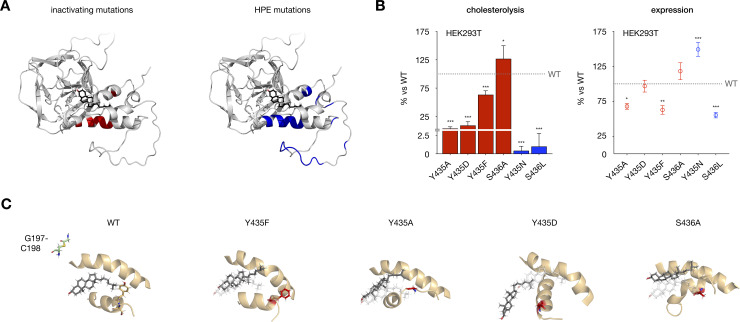
Disease-associated SRR mutations perturb hSHH cholesterolysis.(A) Model of the cholesterol-Hog complex, showing residues essential for cholesterolysis of full-length hSHH protein in HEK293T cells (red; see ref 17) and residues identified in holoprosencephaly (HPE) patients (blue). (B) Relative cholesterolysis efficiency and total expression of full-length hSHH and mutant proteins overexpressed in HEK293T cells, evaluated by quantitative Western blot. Values are the average of 3–9 biological replicates ± s.d. For cholesterolysis, one-way ANOVA, F(6,37) = 121.3, P value P < 0.001, Dunnett’s multiple comparisons test, a = 0.05, ***p < 0.001, *p = 0.02; for expression, one-way ANOVA, F(6,37) = 27.63, P value P < 0.001, Dunnett’s multiple comparisons test, a = 0.05, ***p < 0.001, **p = 0.003, *p = 0.02. (C) 400 ns MD-equilibrated of mutant complexes Y435F, Y435D, and Y435F show progressive displacement of cholesterol from its binding site, while an S436A mutation directs cholesterol toward the G197-C198 thioester.